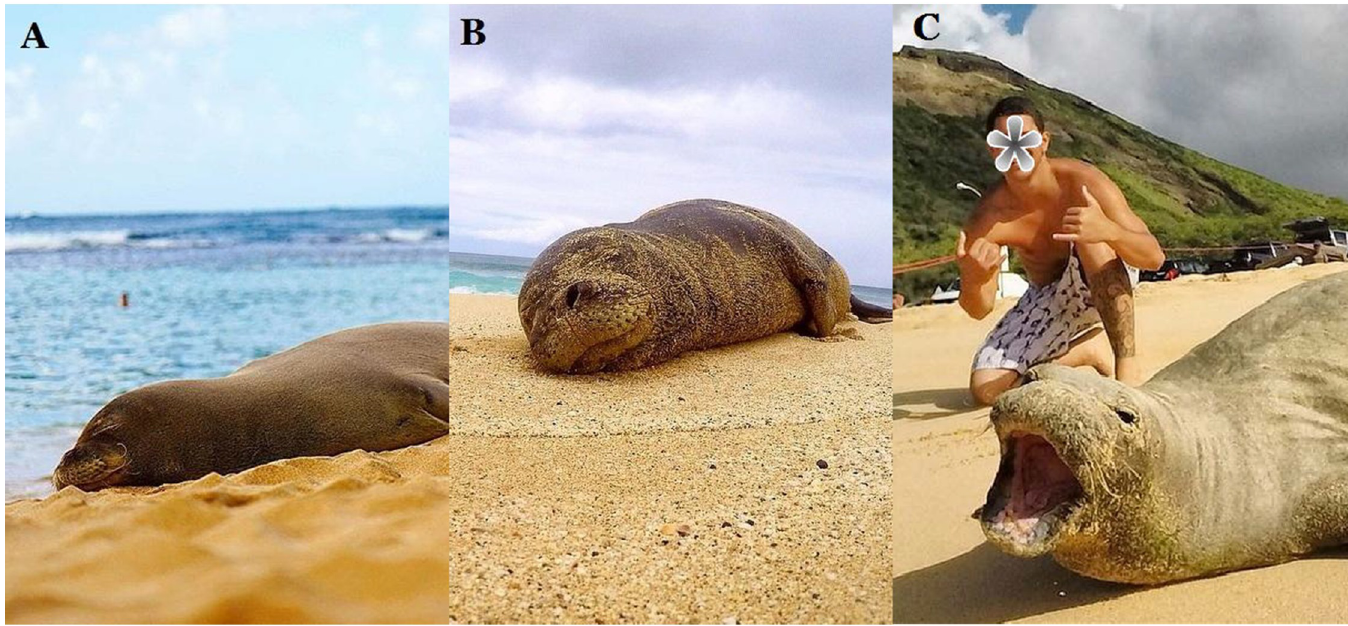
Fig 1. Photo characteristics can be used to judge distance at which photo was taken. A) The blurry foreground and background suggest a zoom lens was used from > 3-m away from the subject. B) All elements are in focus suggesting the use of a wide-angle lens taken from < 3-m from the subject. C) A person < 3-m from a seal and the seal displaying signs of